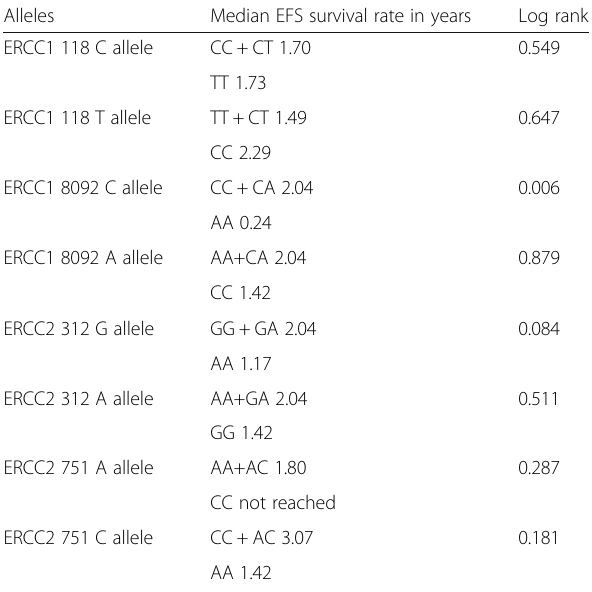
Table 6 Association between Alleles and median EFS rate in osteosarcoma patients treated with cisplatin combinations Alleles